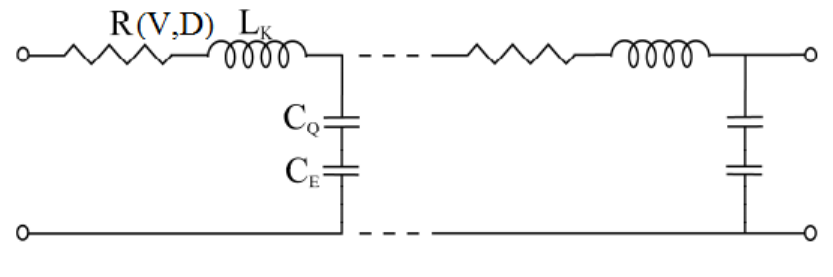
Figure 2. Transmission line model of SWCNT